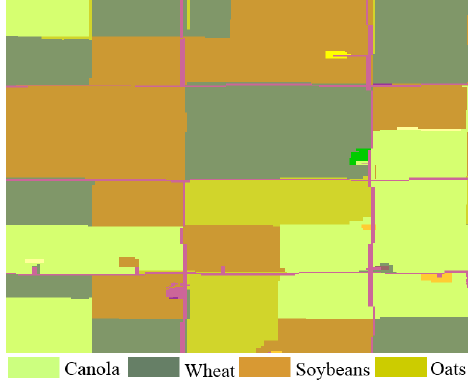
Figure 3. Reference map and its legend